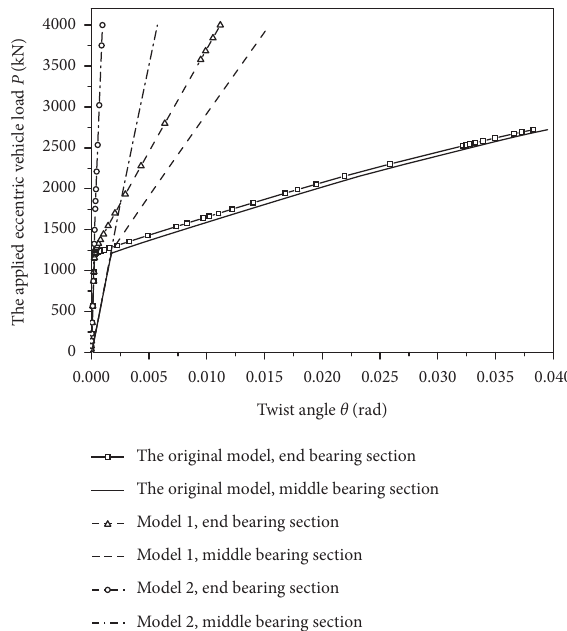
Figure 18: Applied load-twist angle relationships calculated from the models with and without tensile anchors.